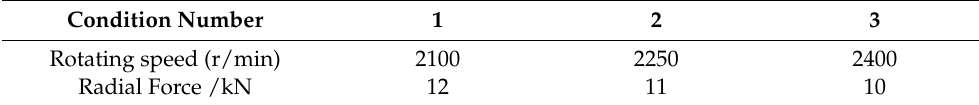
Table 3. Bearing Accelerated Life Test